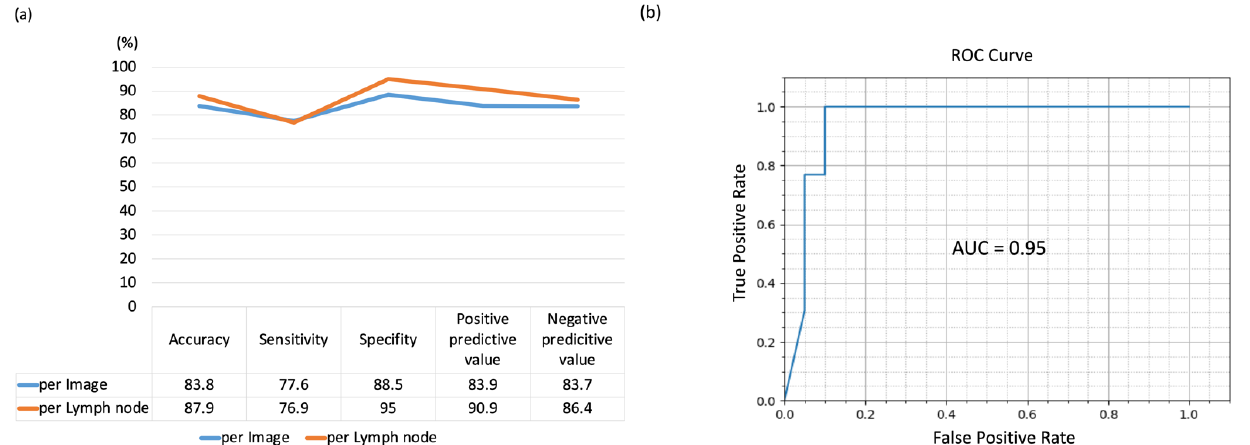
Figure 4. The result of AI-CAD lung cancer lymph node diagnosis accuracy analysis using echo images by hold-out method. ( a ) Diagnostic yield by per image basis and per lymph node basis. ( b ) ROC Curve.